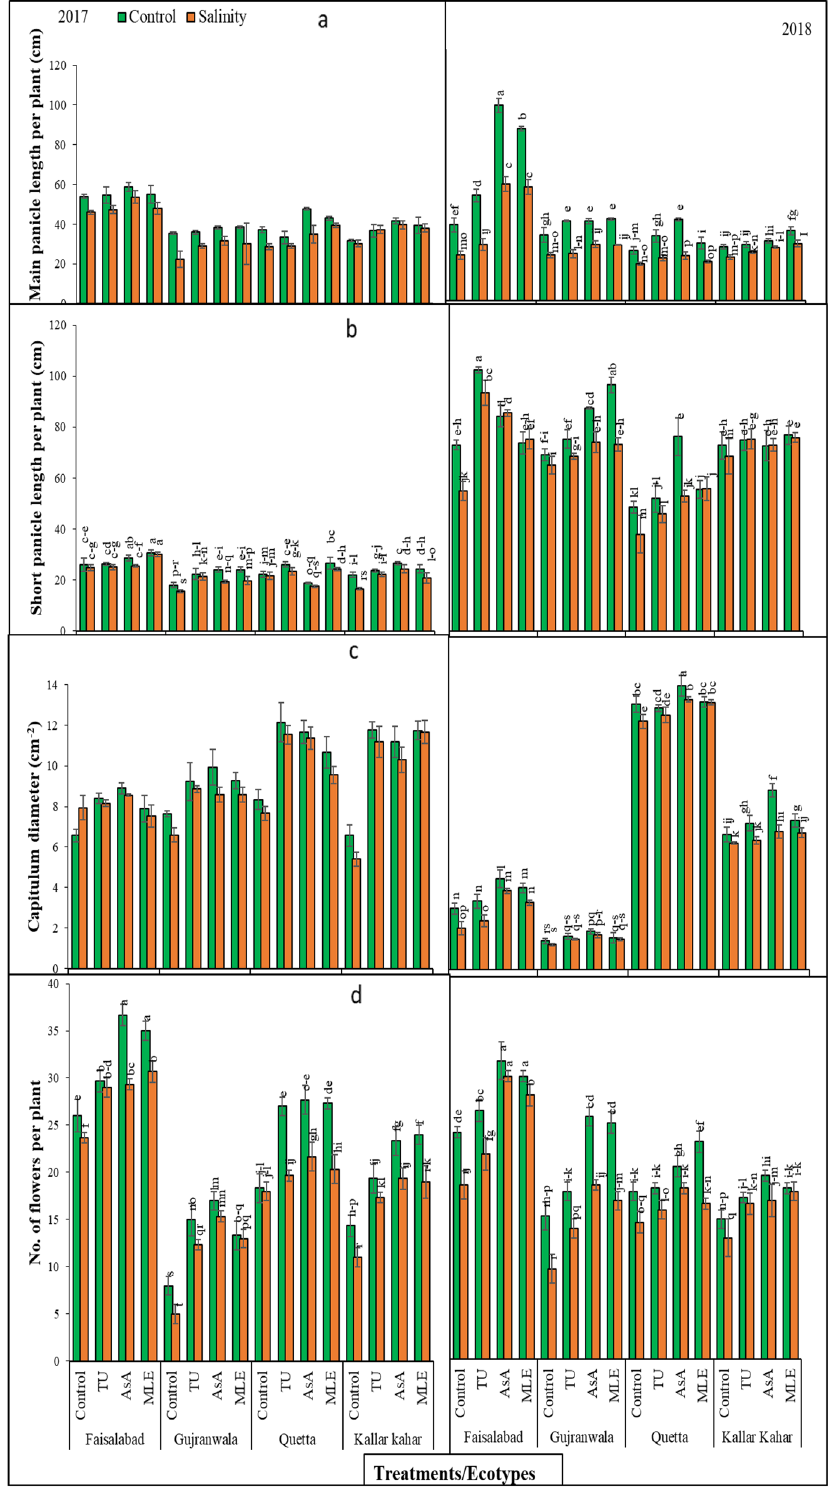
Figure 1. ( a ) Main panicle length, ( b ) short panicle length per plant, ( c ) capitulum diameter, and ( d ) number of flowers per plant of milk thistle under control and salinity stress conditions. The plants were soil supplemented with different plant growth promoters during 2017 and